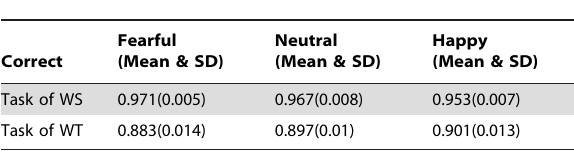
Table 2. Means and standard deviations of the correct percentage (1= 100%) for the word structure (WS) and word tone judgment tasks (WT) when fearful, neutral and happy faces were unattended